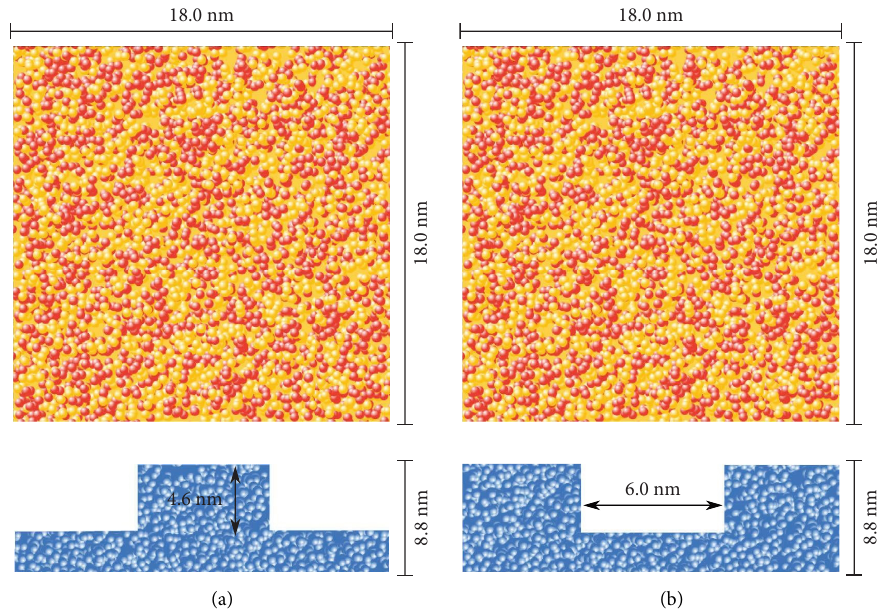
Figure 1: Schematic of (a) tip-like and (b) groove patterns on mold for nanoimprinting process.